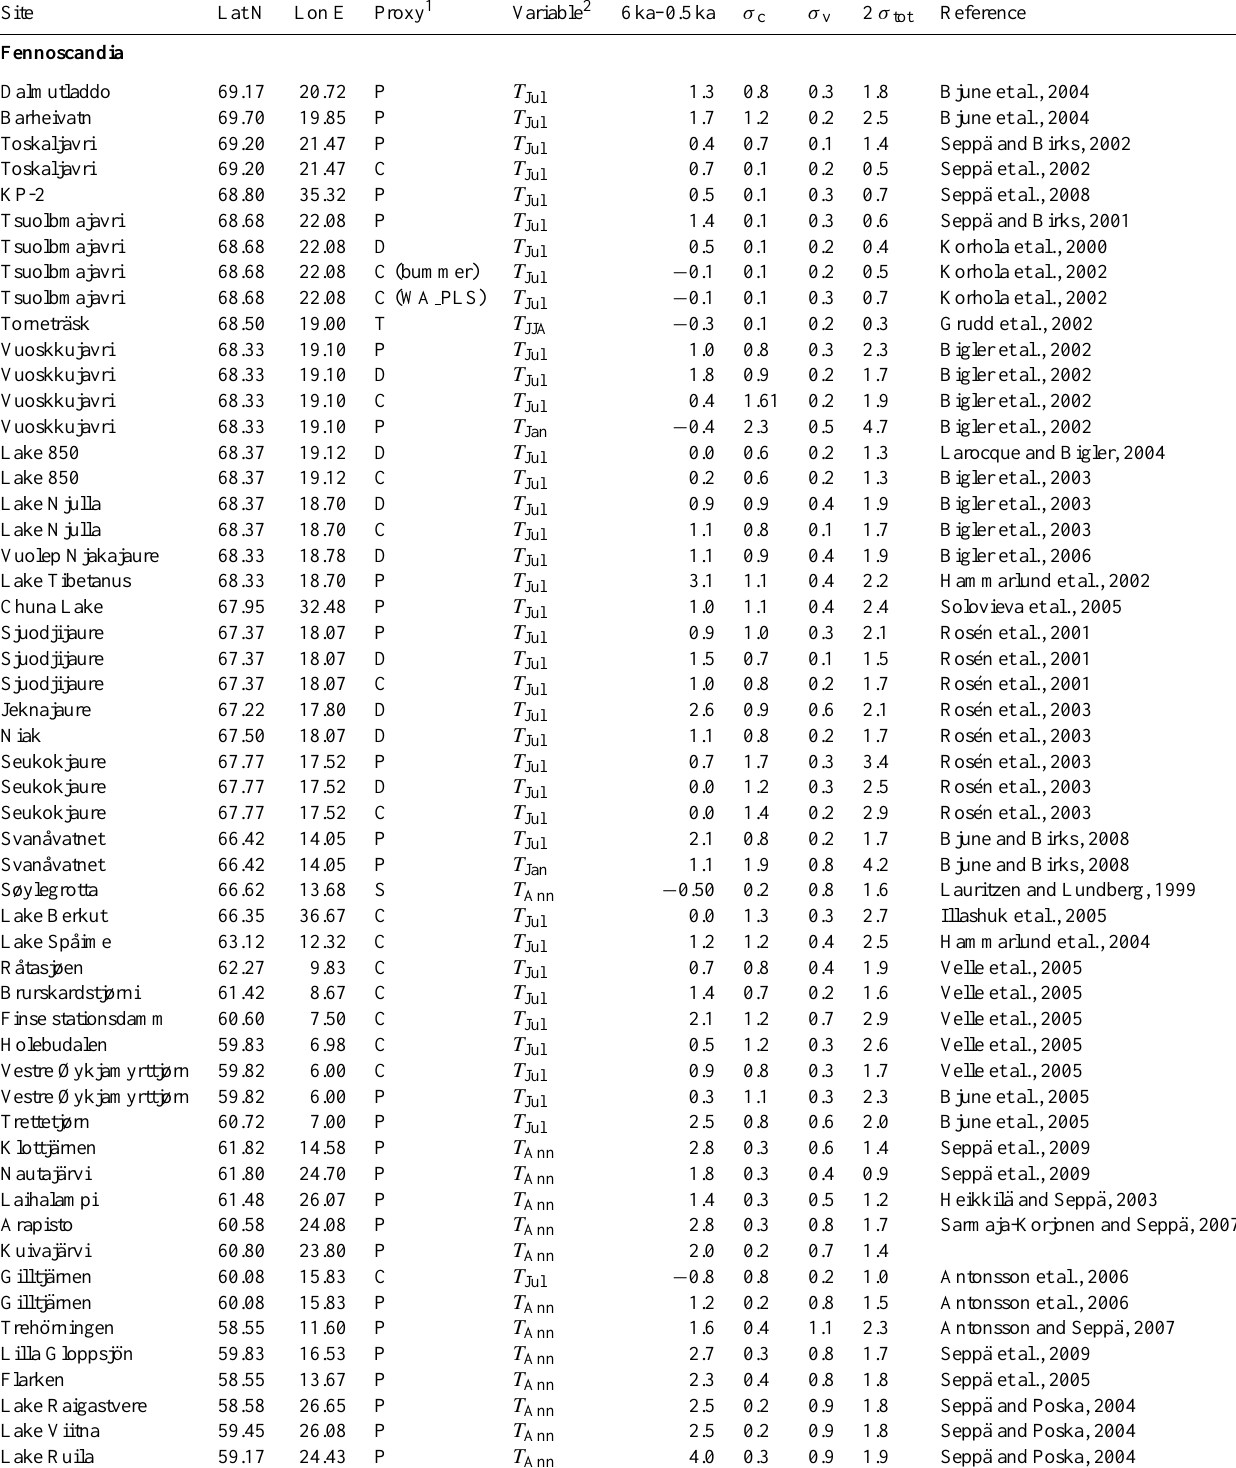
Table 1a. Temperature reconstructions from proxy data discussed in this